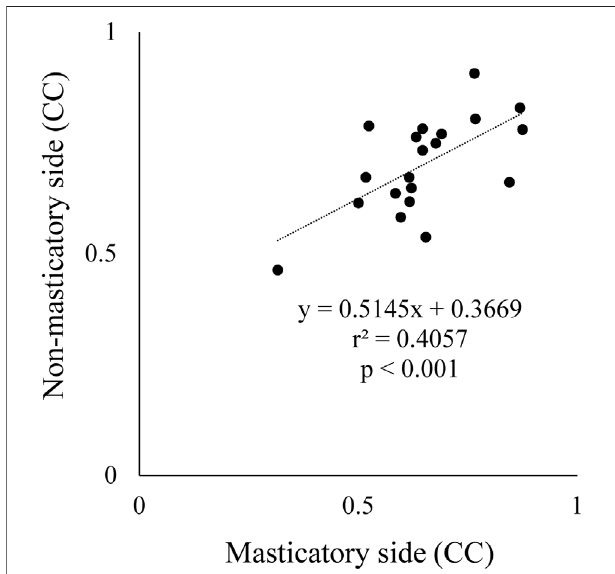
FIGURE 7 | Comparison of correlation coef fi cient (CC) between masticatory and non-masticatory sides. X and Y axes indicate CC data between suprahyoid muscle activity and vertical jaw distance per masticatory cycle on masticatory side and non-masticatory sides, respectively. These were signi fi cantly correlated with each other.